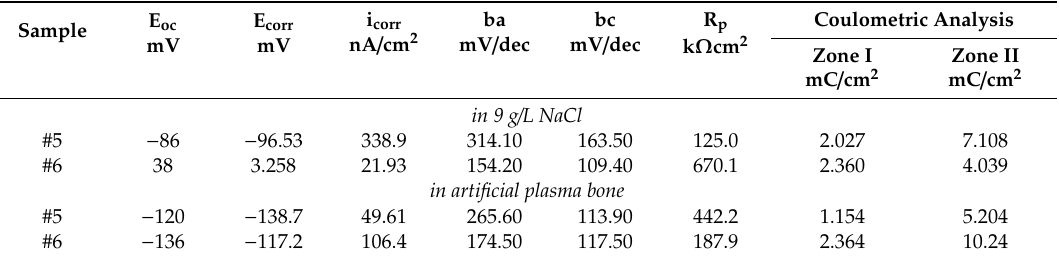
Table 7. Electrochemical parameters determined for Ti6Al4V sca ff old samples in 9 g / L NaCl and in artificial plasma